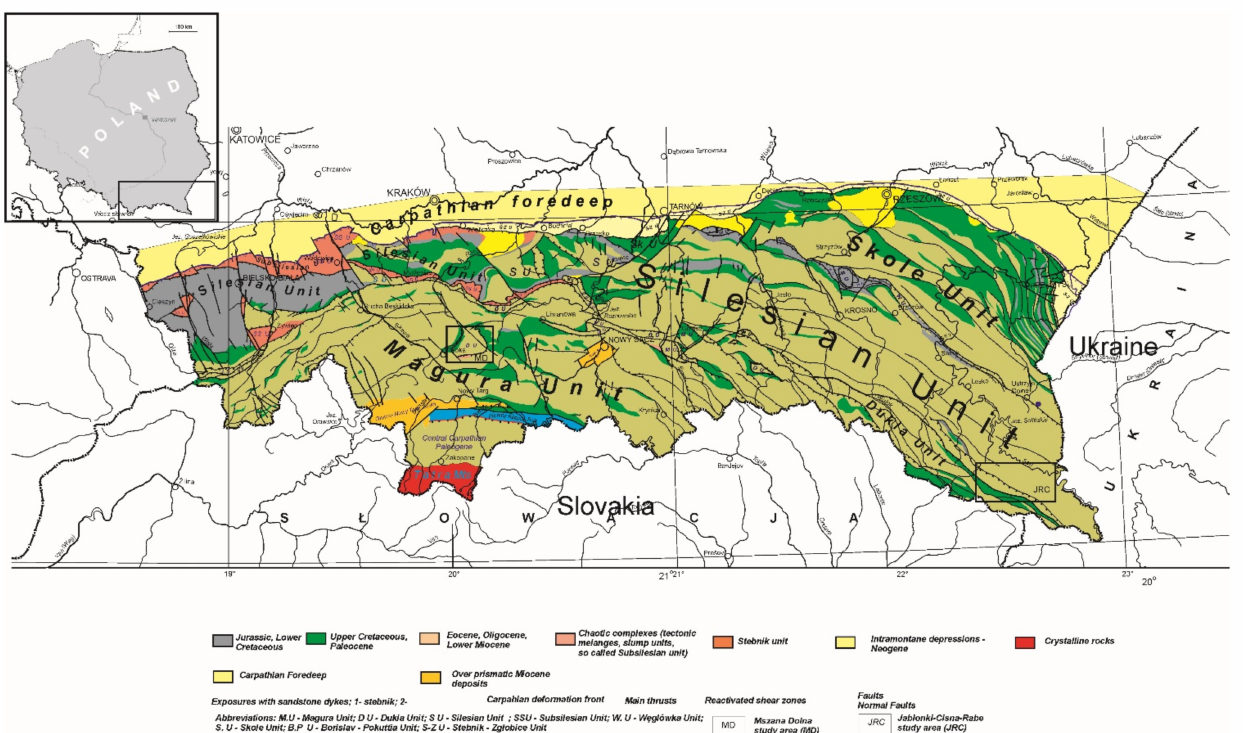
Figure 1. Geological Map of the Outer Carpathians in Poland (after [4],